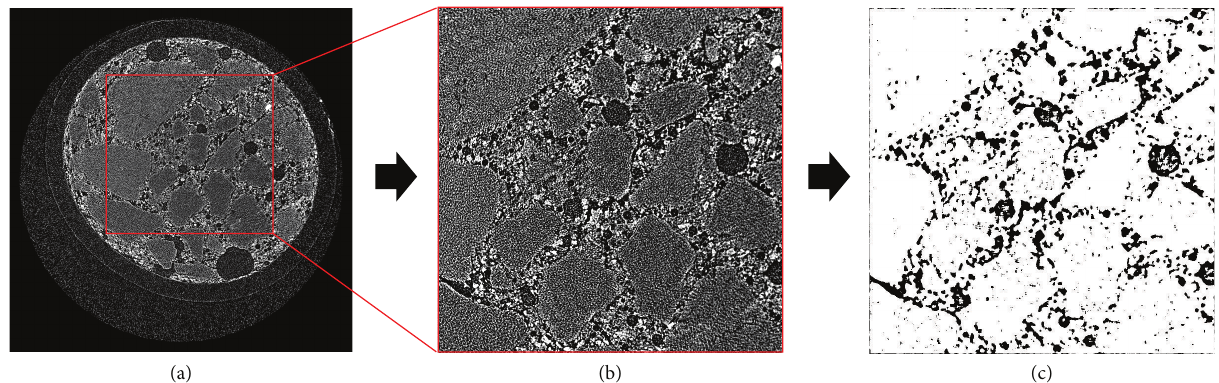
Figure 6: 𝜇 CT imaging to generate a binary image: (a) original 8-bit CT image, (b) squared cross-sectional image, and (c) binary image (white: solid region, black: voids within